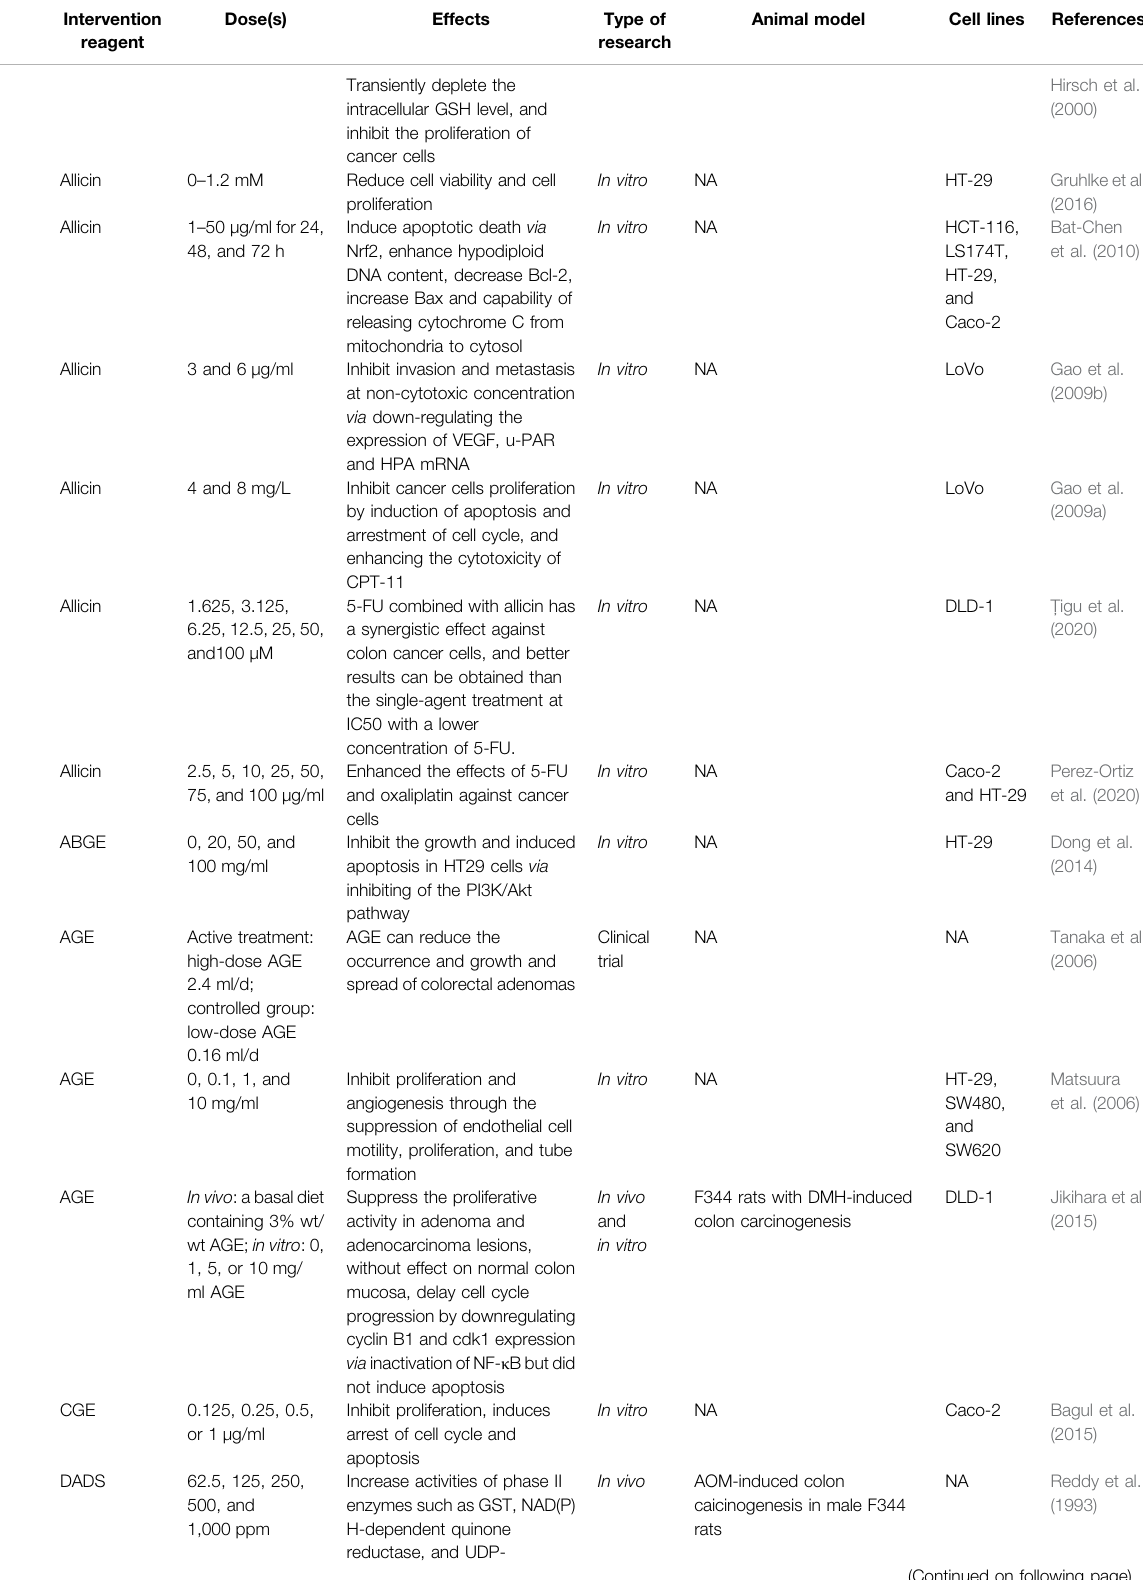
TABLE 1 | ( Continued ) Summary of mechanisms of allicin and its secondary metabolites against cancers of digestive